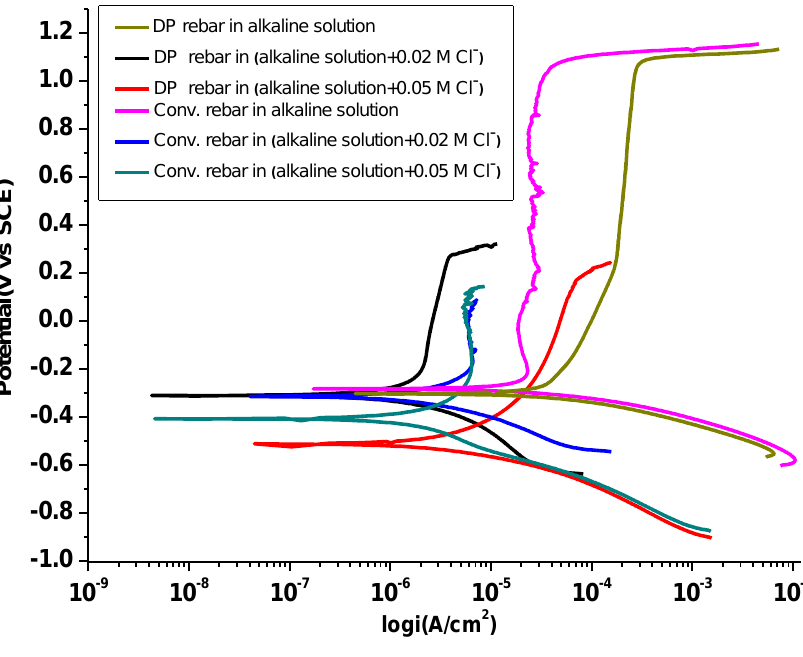
Figure 4. Potentiodynamic polarization curves in simulated concrete pore solution (SCPS) with and without NaCl. SCPS, simulated concrete pore